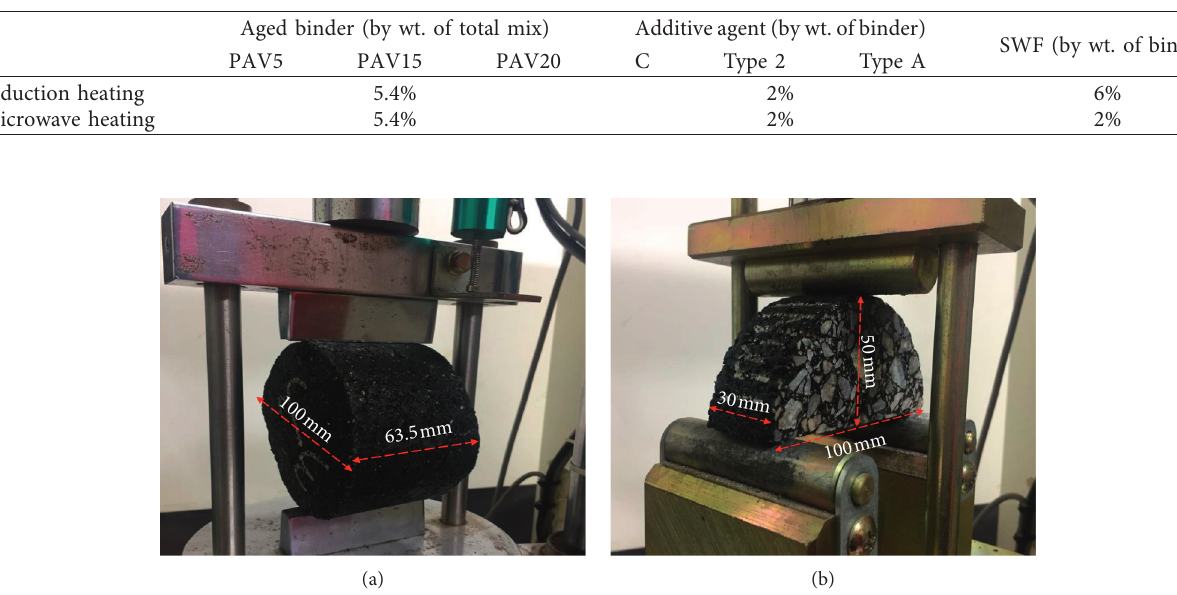
Table 3: Mix proportion of aged series.